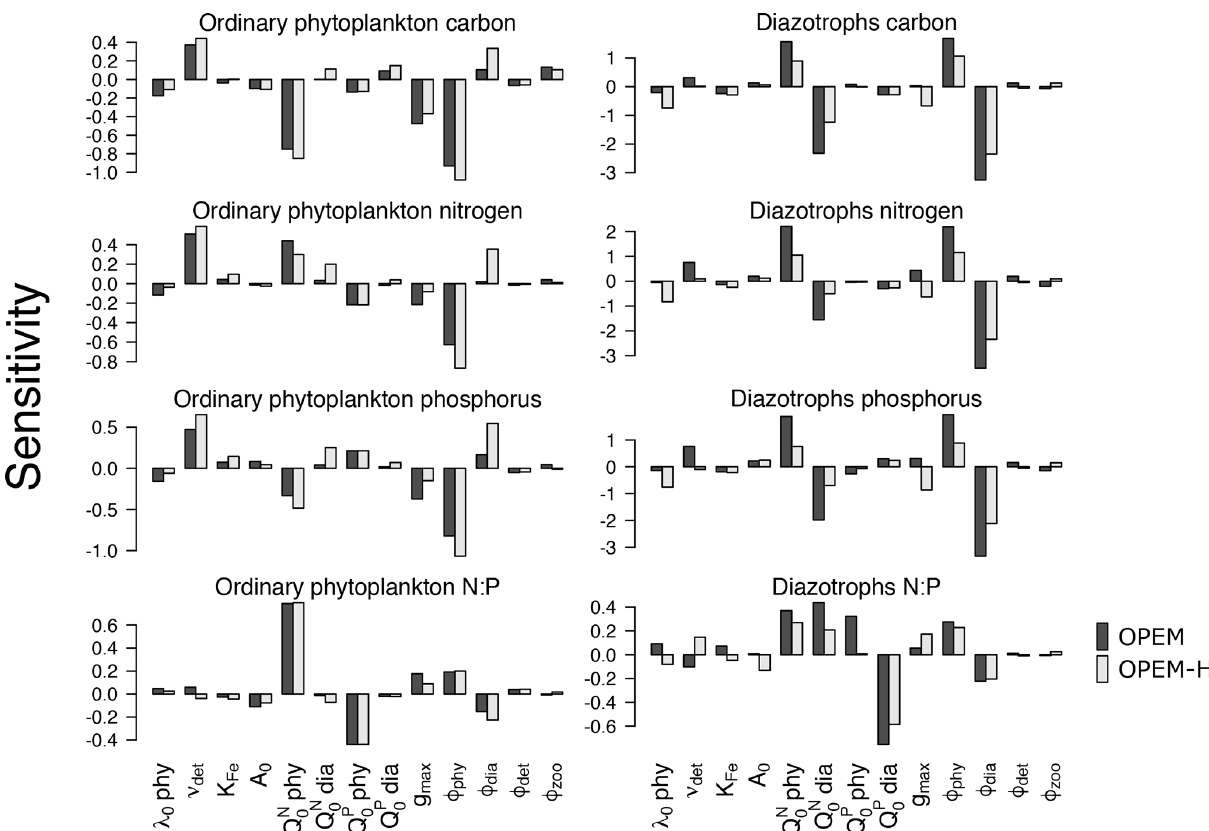
Figure 2. Sensitivities of globally averaged concentrations of ordinary and diazotrophic phytoplankton C, N, and P, and ratios of globally averaged N and P to model parameters. Black and grey shading denotes OPEM and OPEM-H configurations, respectively. Note the different y -axis ranges in the different